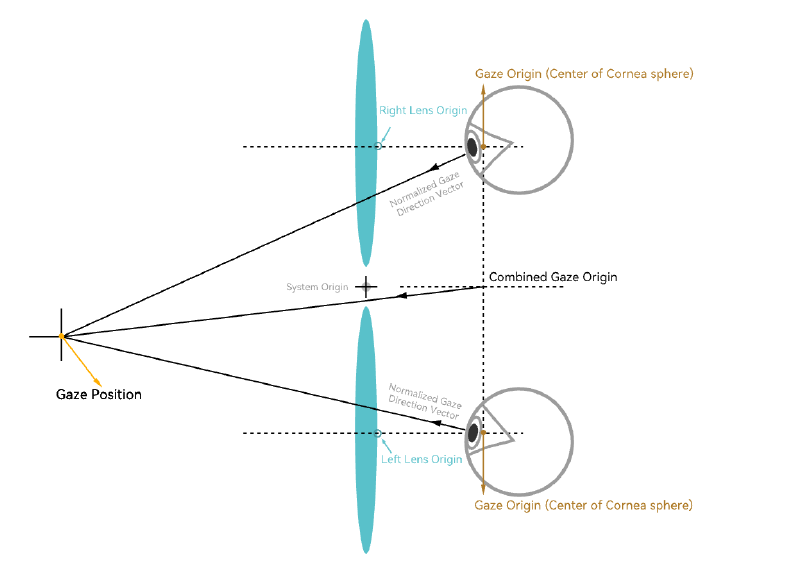
Figure 3. Eye tracker output data